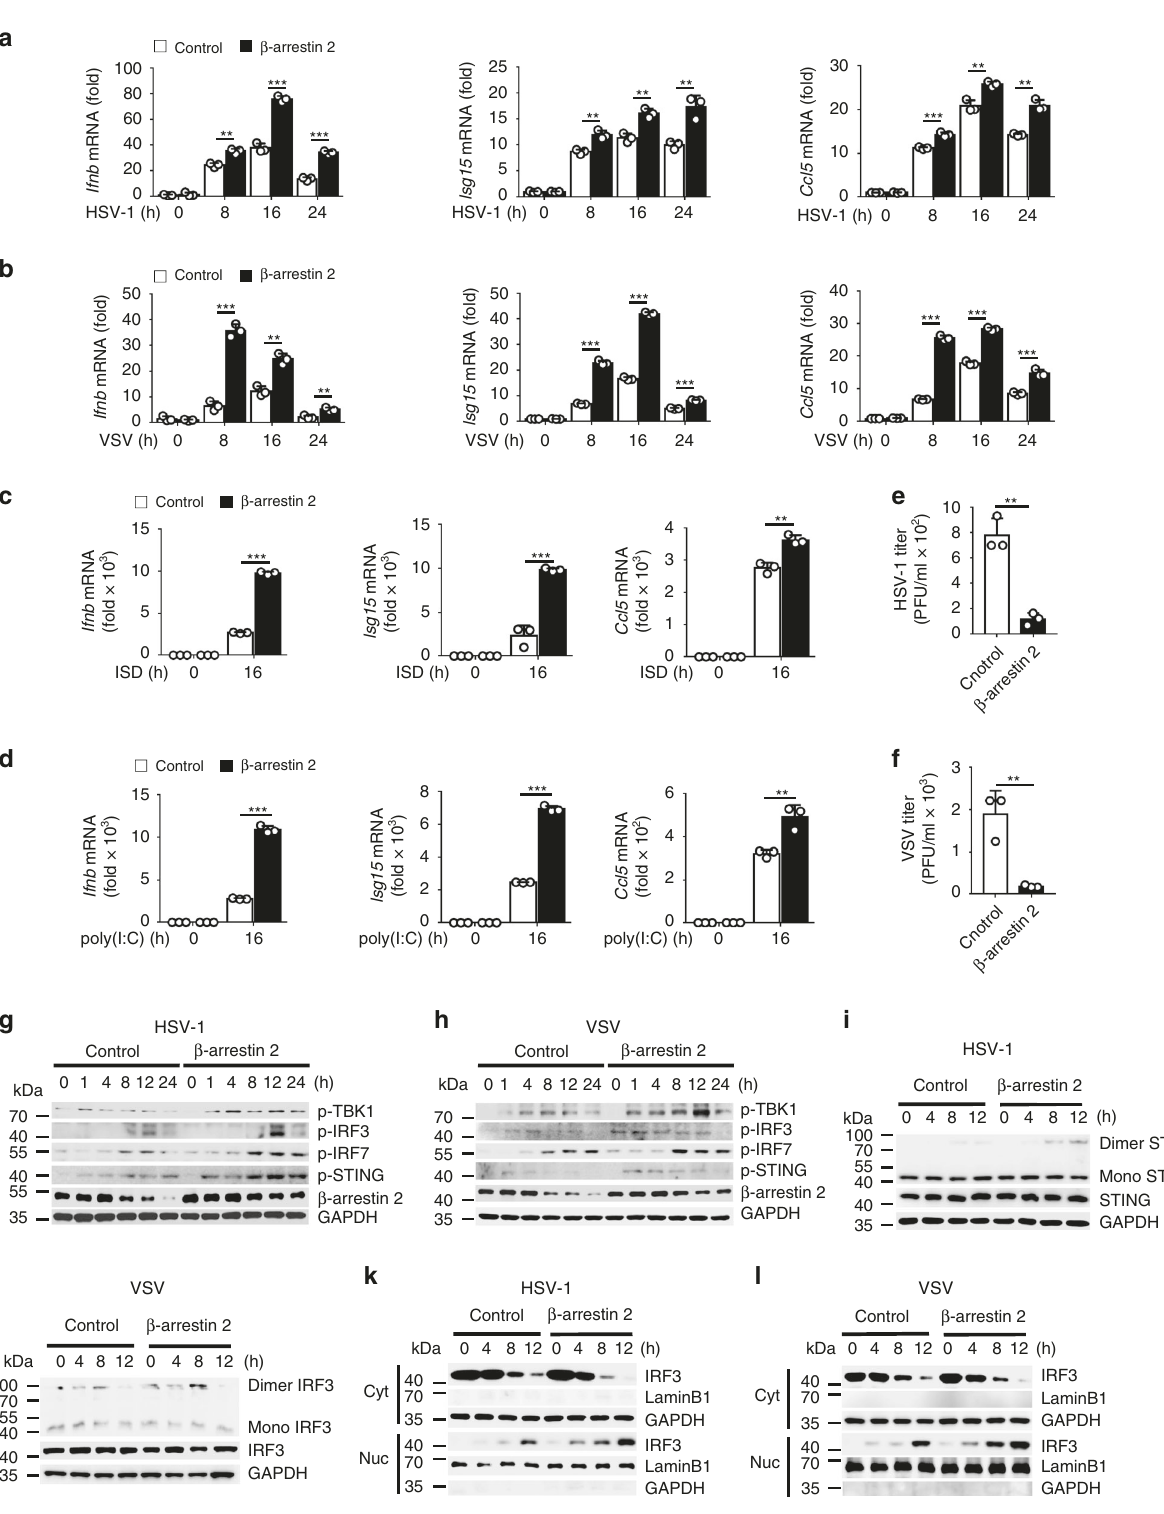
Fig. 2 β -arrestin 2 positively regulates IFN- β signaling. a – d Ifnb , Isg15 , and Ccl5 mRNA levels in L929 cells transfected with control or β -arrestin 2 vectors and stimulated with HSV-1 a (** P = 0.0018, *** P < 0.0001, < 0.0001 in sequence, left panel; ** P = 0.0040, 0.0028, 0.0050 in sequence, middle panel; *** P = 0.0006, ** P = 0.0044, 0.0010 in sequence, right panel), VSV b (*** P < 0.0001, ** P = 0.0015, 0.0071 in sequence, left panel; *** P < 0.0001, < 0.0001, = 0.0001 in sequence, middle panel; *** P < 0.0001, < 0.0001, = 0.0009 in sequence, right panel), ISD c (*** P < 0.0001, left panel; *** P = 0.0004, middle panel; ** P = 0.0025, right panel), or poly(I:C) d (*** P < 0.0001, left panel; *** P < 0.0001, middle panel; ** P = 0.0067, right panel) for indicated times. e , f The virus titers as in a or b for 72 h (** P = 0.0013 in e , ** P = 0.0062 in f ). g , h Immunoblot of lysates of L929 cells transfected with control or β - arrestin 2 vectors and infected with HSV-1 g or VSV h for indicated times. i , j Immunoblot analysis of monomeric and dimeric STING i and IRF3 j as in g or h . k , l Immunoblot analysis of nuclear and cytoplasmic fractions as in i or j . Data are representative of at least three independent experiments (mean ± SEM in a – f , n = 3). Two-tailed unpaired Student ’ s t